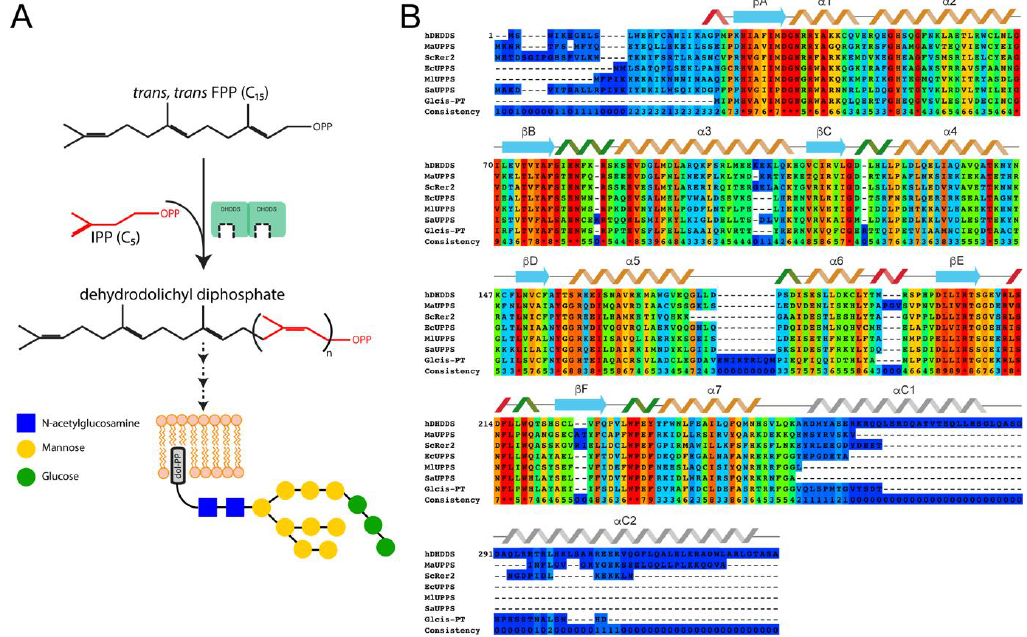
Figure 1. Catalytic cycle of human dehydrodolichyl diphosphate synthase (DHDDS) . ( A ) Multiple condensations of a farnesyl diphosphate (FPP) primer with isopentenyl diphosphate (IPP) result in the formationDHDDbyDHDDS.DHDDisfurtherprocessedtoformDol-P,thecarrieroftheoligosaccharide used for N-glycosylation. ( B ) Sequence alignment of cis -prenyltransferases, with conservation scores calculated by PRALINE. Human DHDDS (hDHDDS), Methanosarcina acetivorans UPPS (MaUPPS), Saccharomyces cerevisiae Rer2 (ScRer2) are components of heteromeric cis -prenyltransferase complexes; Escherichia coli UPPS (EcUPPS), Micrococcus luteus UPPS (MlUPPS), Sulfolobus acidocaldarius UPPS (SaUPPS), and Giardiasis lambia cis -PT (Glcis-PT) are homodimeric cis -prenyltransferases. The